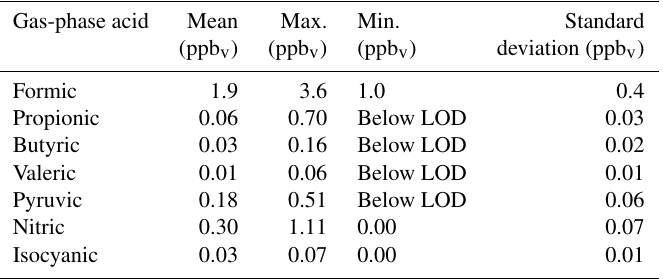
Table 1. Campaign statistics for measured gas-phase acids.